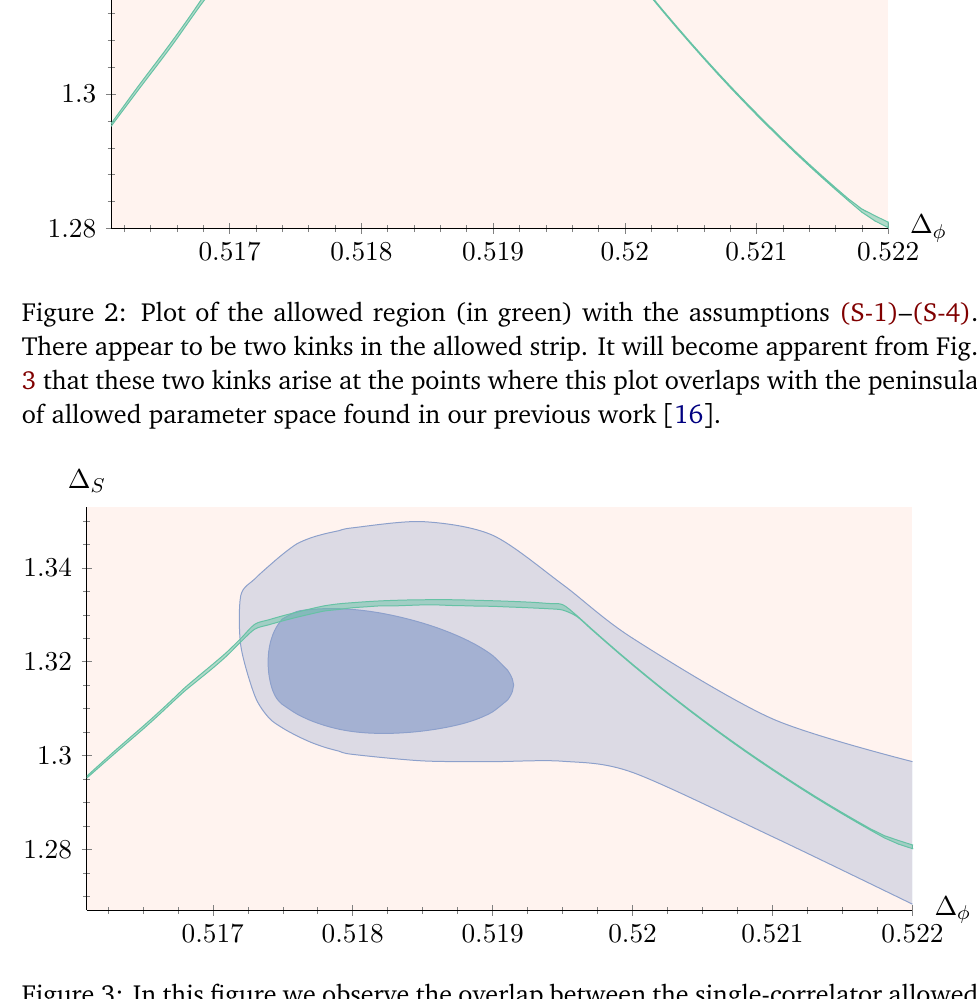
Figure 3: In this figure we observe the overlap between the single-correlator allowed region from this work (in green), and the allowed peninsula and island from our previous mixed-correlator work [ 16 ] (in blue). Both the peninsula and island assume that the theory lives on the X sector single-correlator bound of Fig. 1, and also that the next-to-leading operator in the scalar X sector has a scaling dimension of 3 or higher. Additionally, the island assumes that S (cid:48) has a dimension of 3.7 or higher. The peninsula assumes that S (cid:48) has a dimension of 3 or